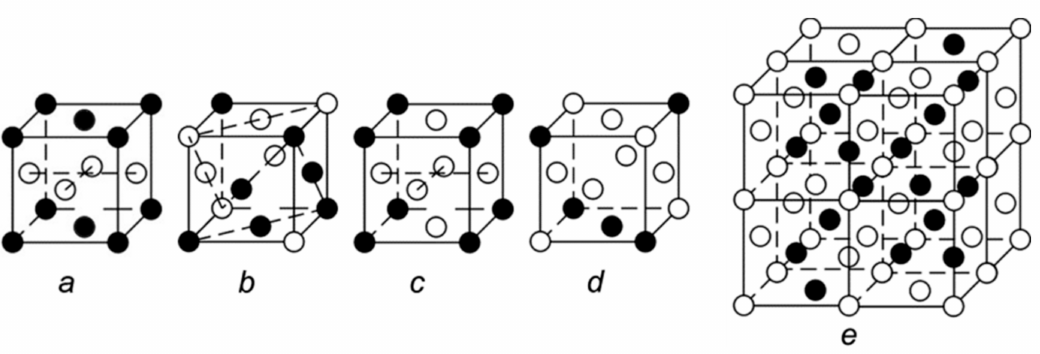
Figure 2. Unit cell of the sample superstructures: L1 0 ( a ), L1 1 ( b ), L1 2 ( c ), L1 3 ( d ), and Ga 3 Pt 5 ( e ). Reproduced with permission [23]. Copyright 2013 Springer